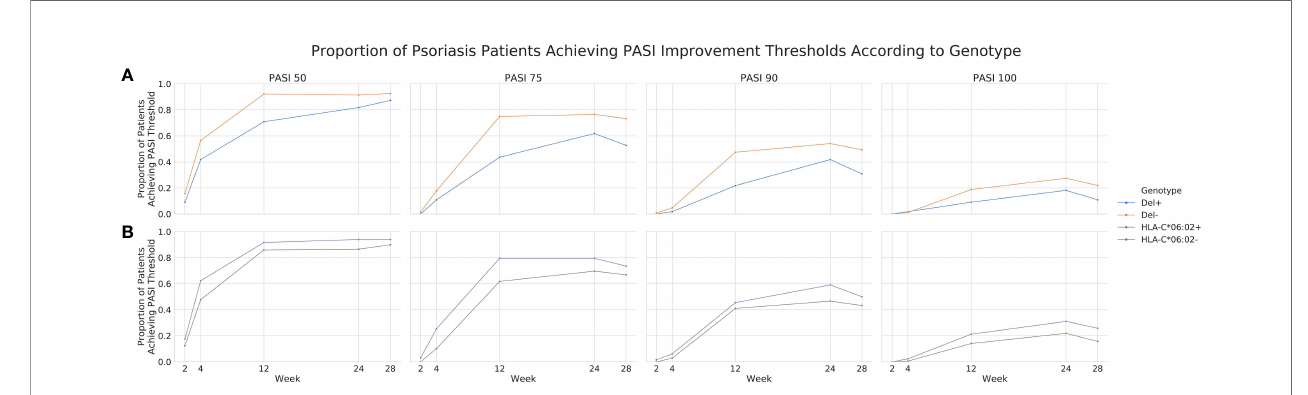
FIGURE 3 | Proportion of psoriasis patients achieving PASI thresholds according to genotype in cohort 1. PASI 50, 75, 90 and 100 achievement across weeks 2, 4, 12, 24 and 28 for rs35569429 (A) and HLA-C*06:02 (B) genotypes.